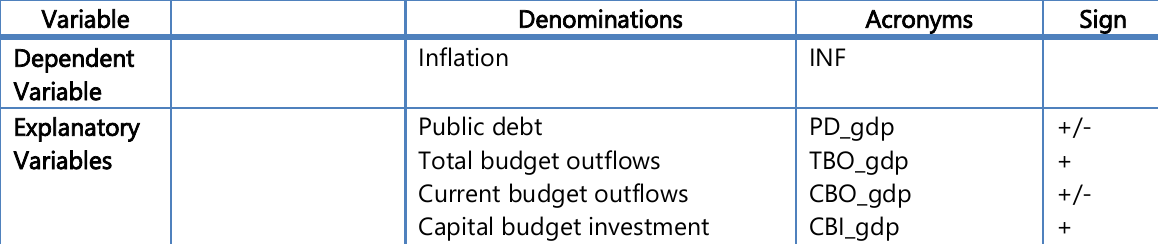
Table 1: Variable Descriptions and Expected Sign (Source: Own research) Variable Denominations Acronyms Sign